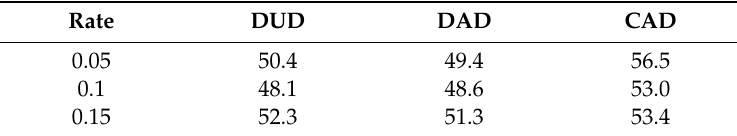
Figure 12. CAD with rate of ( a ) 0.05; ( b ) 0.1 and ( c ) 0.15. Table 1. Error Percentage for testing data.